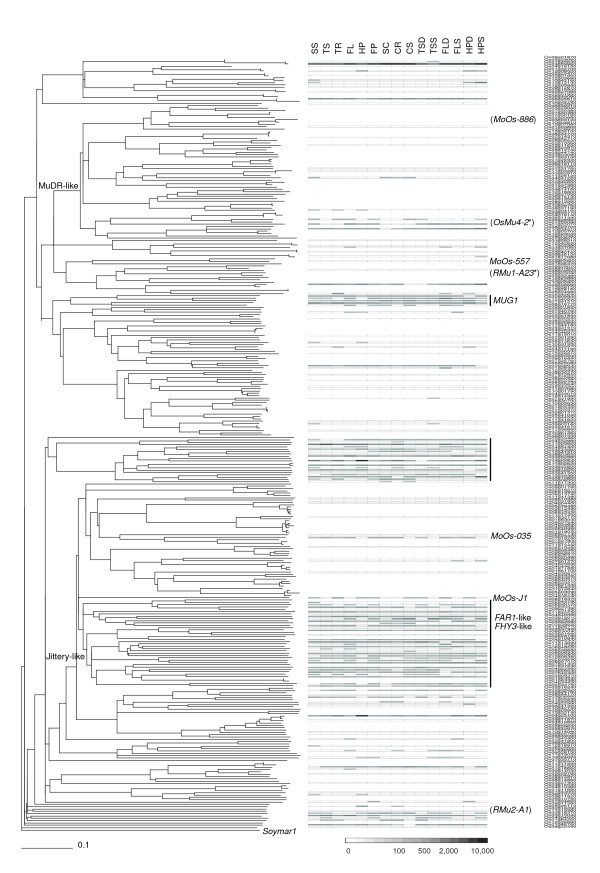
Degrees of lineage-specific transcription in MULE superfamily (excluding the TRAP-like class). The phylogenetic tree was generated from a multiple alignment of conceptually translated sequences by using neighbor-joining methods and rooted with soybean Soymar1. Bootstrap values were calculated from 1,000 replicates. Sample numbers are identical to those in Table 2. Shades of gray indicate the magnitude of transcription signals, which are based on microarray hybridization signals without units. Names of previously reported members are shown. Names in parenthesis indicate members not covered by microarray. Transcriptional active clades are highlighted by bars. *Previously reported members with transcription or transposition.